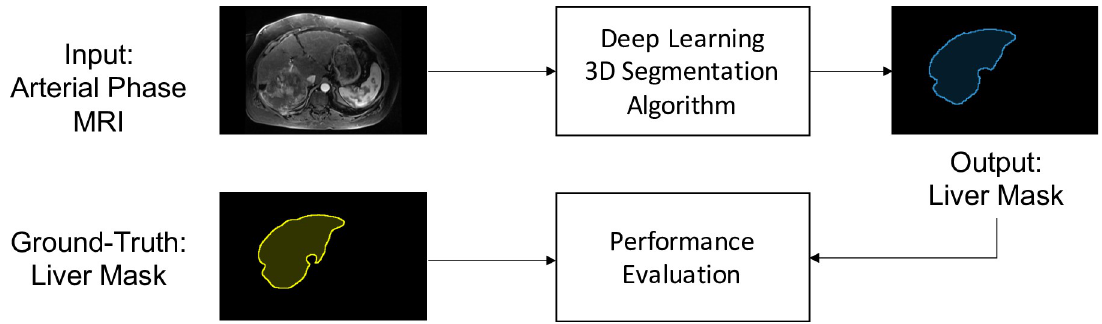
Fig 1. Overview of the training and evaluation framework for the automated 3D liver segmentation method. Training input consists of 3D arterial-phase magnetic resonance image (MRI) volumes with corresponding manually annotated ground-truth liver segmentation masks. To evaluate model performance in an independent test set, the output liver segmentations were compared to annotated ground- truth.